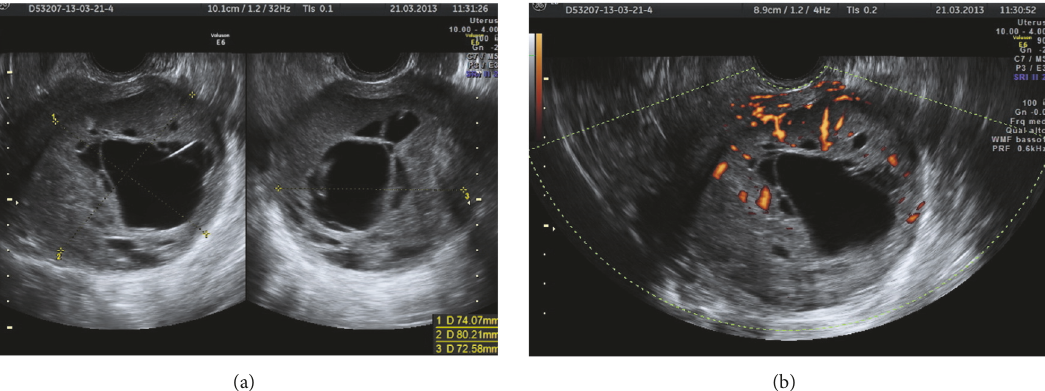
Figure 1: (a) M-Mode findings: enlarged uteruswith inhomogeneous echogenicity. (b) Power Doppler findings: multiple anechoicareas with central and peripheral